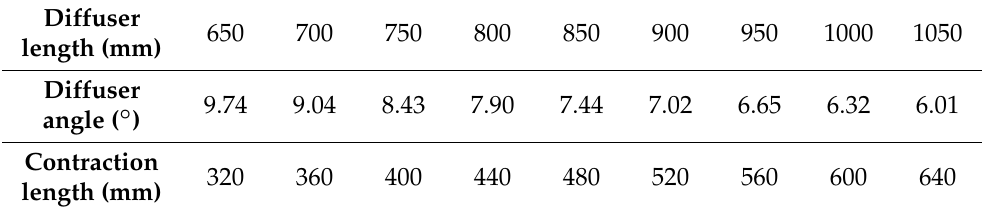
Table 1. Lengths of diffuser and contraction section.